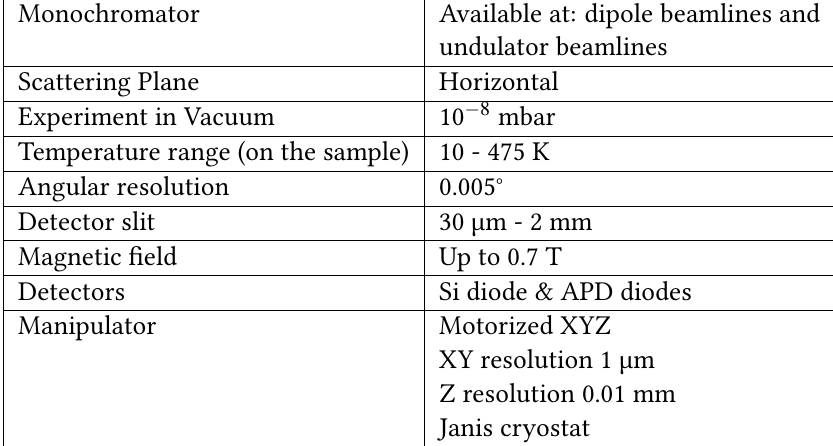
Table 1: Technical parameters of the ALICE